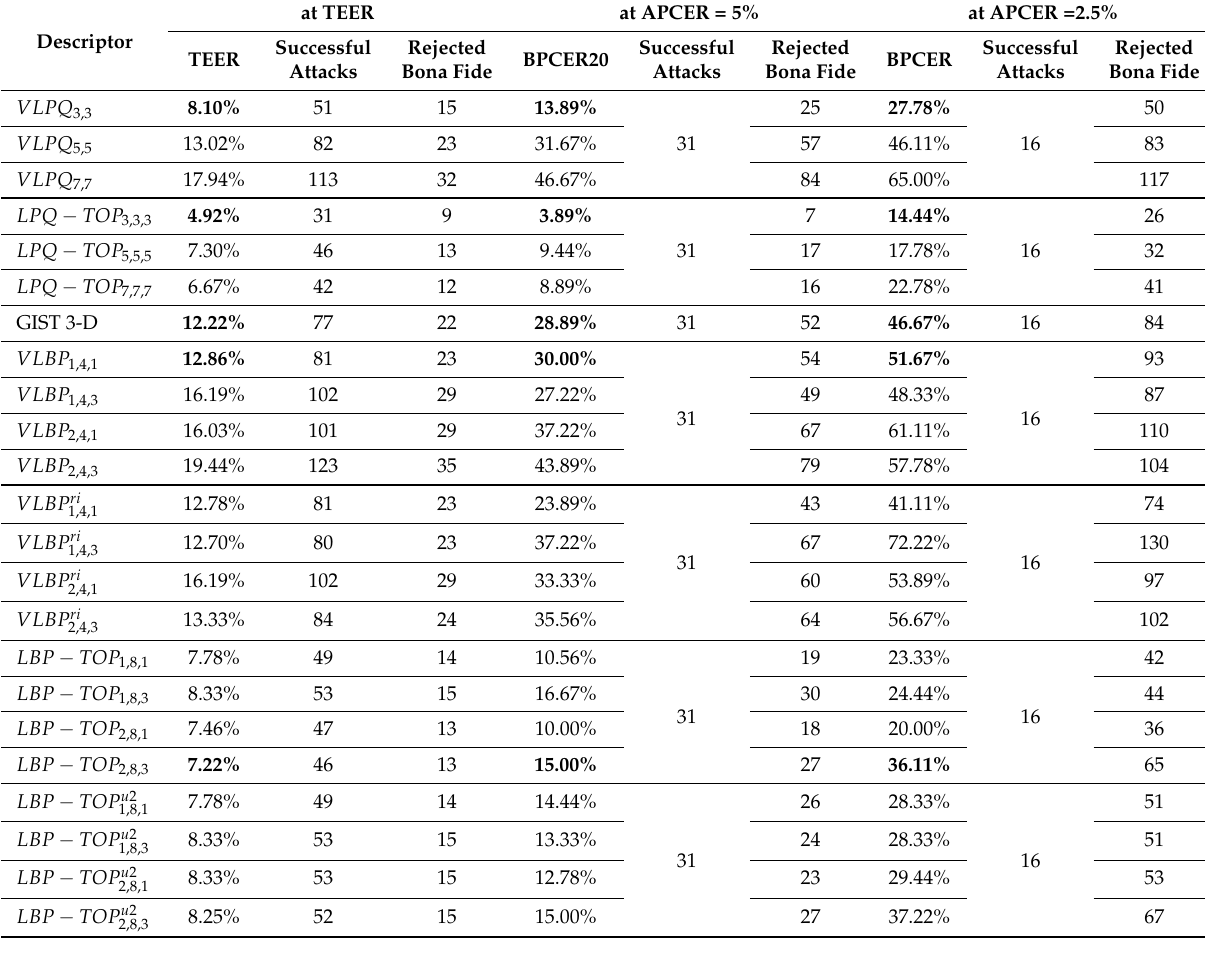
Table 6. PAD subsystem performance for the thermal sensor.